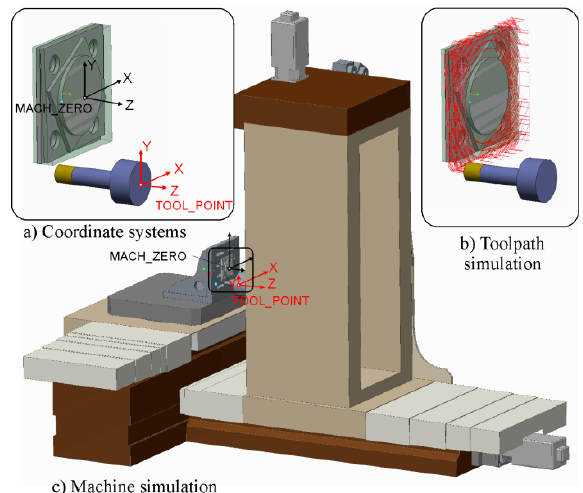
Figure 4. Coordinate systems of the workpiece and tool for the toolpath and machine simulation